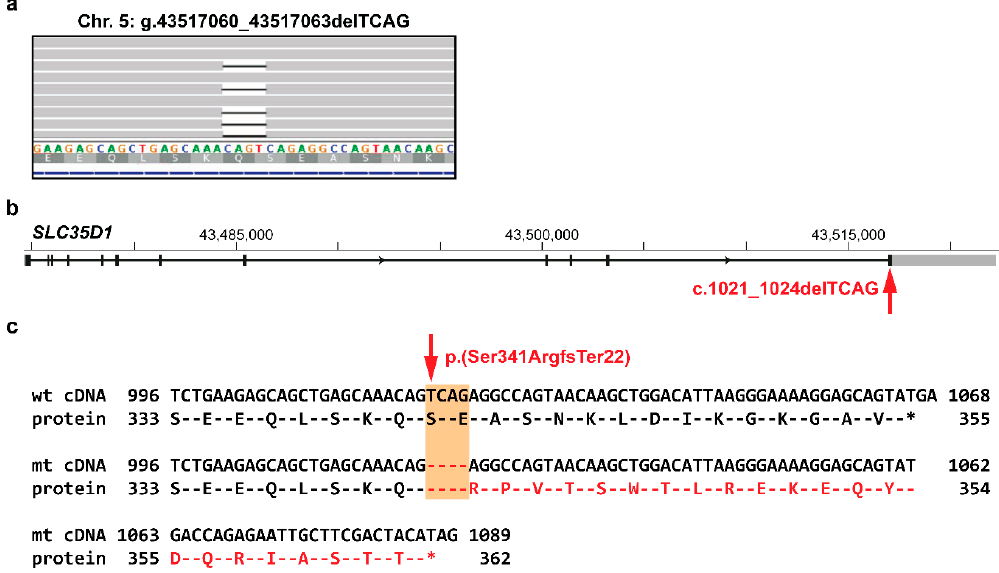
Figure 4. Characterization of the identified functional candidate variant in SLC35D1 in the CMO- affected Weimaraner. ( a ) IGV snapshot showing the heterozygous frameshift candidate variant (NC_006587.3:g.43517060_435178063delTCAG), note that the variant description is adapted to the 3' rule [22]. ( b ) Schematic representation of the SLC35D1 gene with the variant affecting the last exon. ( c ) Comparison of wild type and the predicted mutant C-terminus protein sequence based on cDNA entry XM_003434643.2. The variant (XP_003434691.1:p.(Ser341ArgfsTer22)) affects the last 15 amino acids of